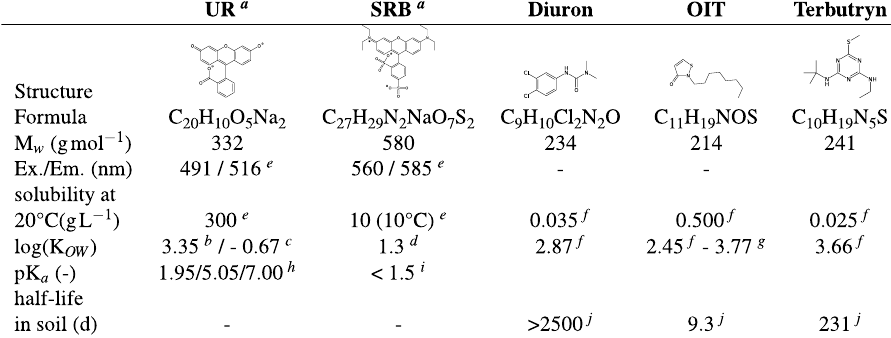
Table 3. Characterisation of fluorescent tracers and biocides. a Color Index (Name:Number): UR (Acid Yellow 73 : 45350) 58 ; SRB (Acid Rd 52 : 45100) 58 ; b log( K OW ) for the twofold protonated (neutral) species (dominant species between pH 1.95 and 5.05), Calculated with Estimation Programs Interface Suite for Microsoft Windows, v 4.11 99 ; c log( K OW ) for the disodium salt (twofold negative charged) species (dominant species above pH 7.00), Calculated with Estimation Programs Interface Suite for Microsoft Windows, v 4.11 99 ; d log( K OW ) at pH 7.15 100 ; e Source: 58 ; f Source: 94 ; g Source: 101 ; h Source: 102 ; i Source: 103 ; j Source: 29